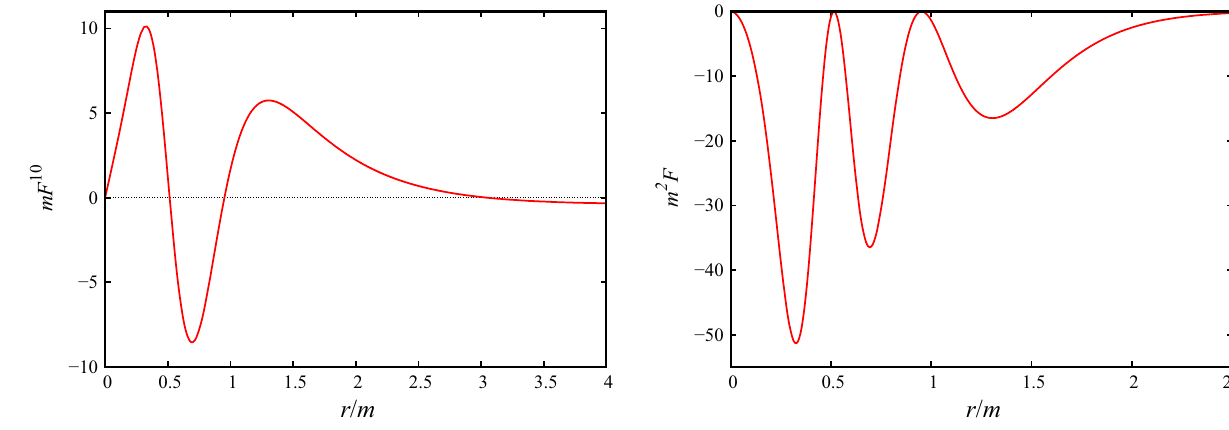
Fig. 9 Graphical representation of the electric field and the electromagnetic scalar for mc 1 = 1 and q = 0 . 7 m